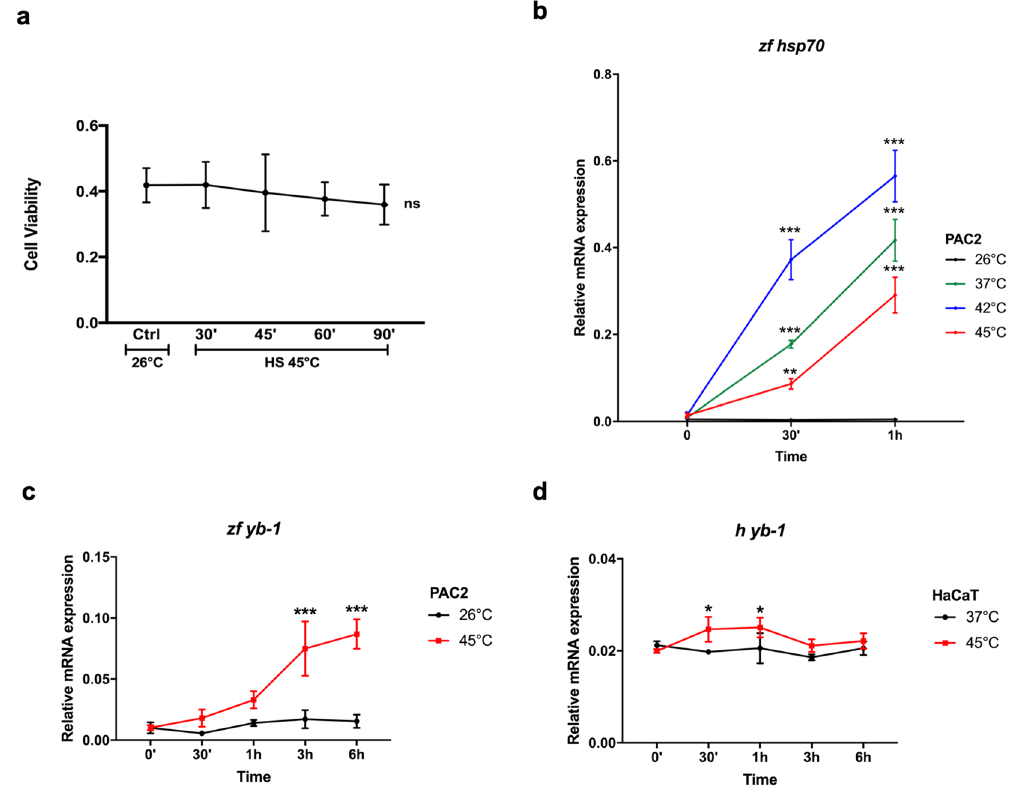
Figure 2. Heat shock induces yb-1 transcript levels in zebrafish but not in mammalian cells. (a) cell viability of PAC2 cells after heat shock treatment at 45 °C. Cells were subjected to elevated temperatures for the times indicated on the x-axis and cell viability values (MTT) are plotted on the y-axis. Statistical analysis was performed using 1-way ANOVA followed by Dunnett’s multiple comparisons test; ns indicates no statistical significance (see also Table S1); ( b–d) RT-qPCR analysis of zebrafish zf hsp70 ( b ), zf yb-1 ( c ) in PAC2 cells and human h yb-1 ( d ) in HaCaT cells. Samples were taken at different time points during and after 1 hour of heat shock treatment at the indicated temperatures (for precise experimental details, see materials and methods section). Mean mRNA relative expression (n = 3) ± SD is plotted on the y-axes, whereas time is plotted on the x-axes. Statistical analysis was performed using 2-way ANOVA and Sidak’s multiple comparison test. Levels of significance between points of expression and time 0 are indicated ( *** p < 0.001, ** p < 0.01, * p < 0.05) (see also Table S1 for statistical